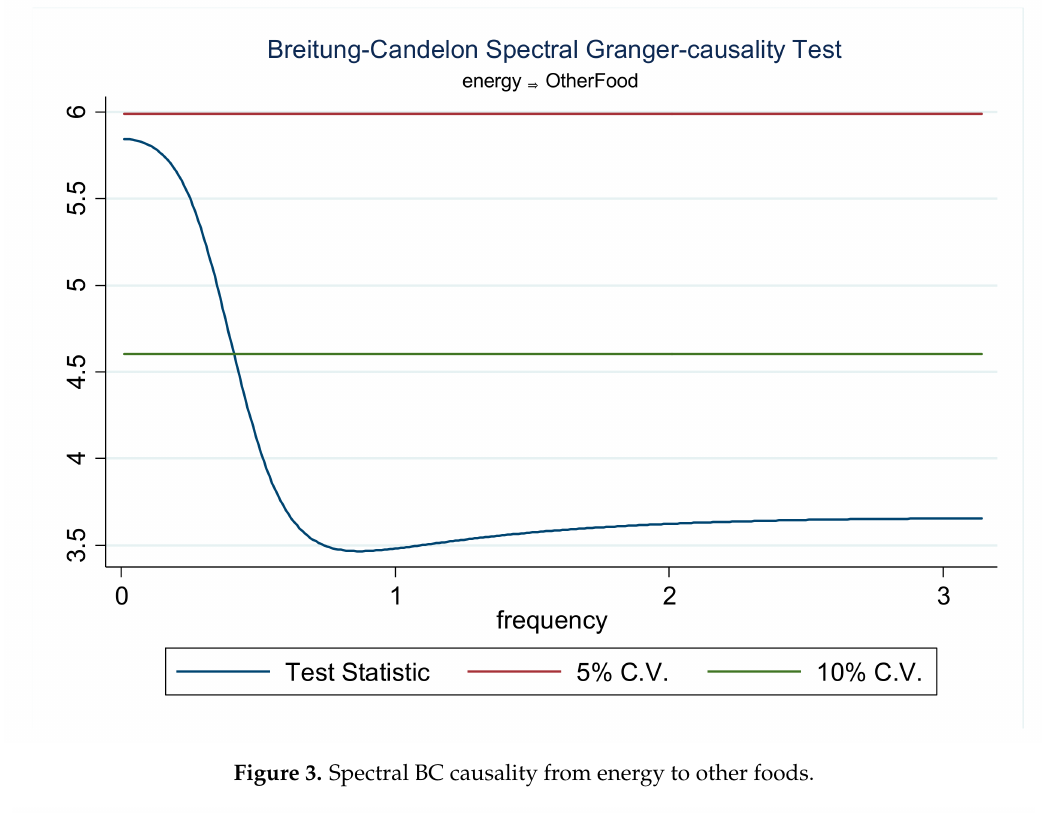
Figure 3. Spectral BC causality from energy to other foods.